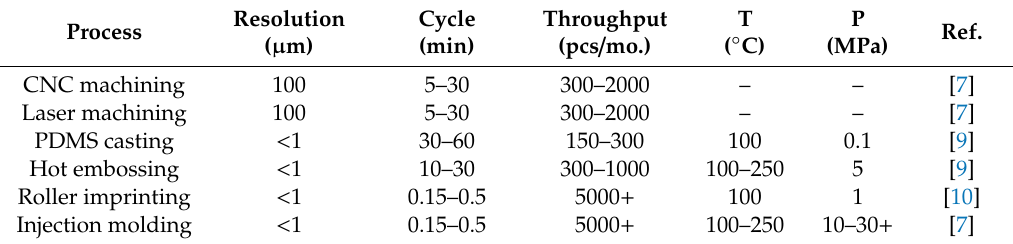
Table 1. Comparison of manufacturing processes for micro-featured device